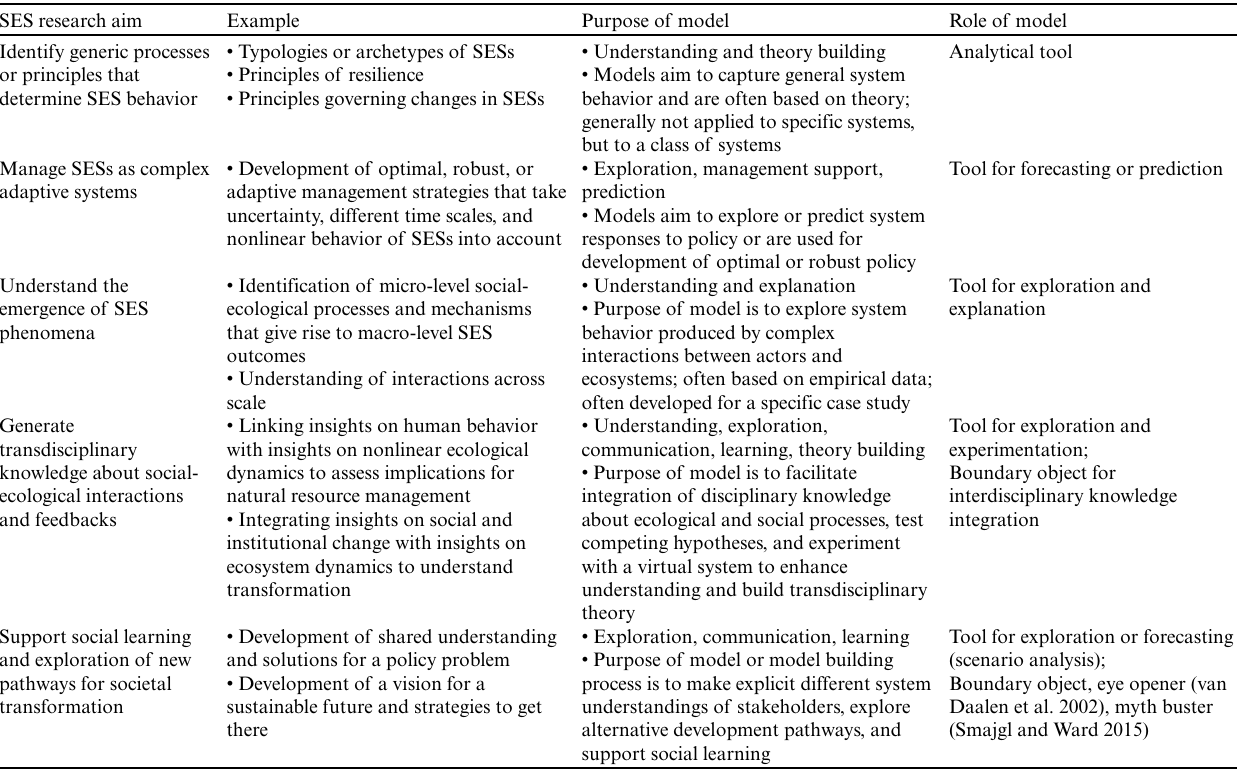
Table 1. Social-ecological systems (SESs) research aims and corresponding model purposes and